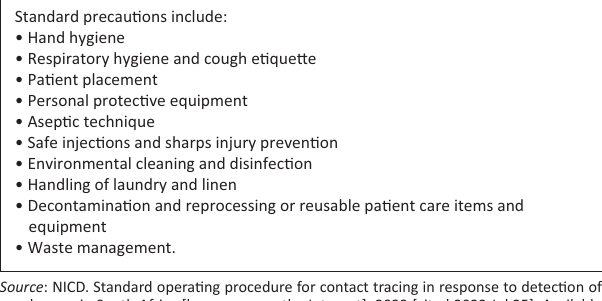
FIGURE 5: Infection prevention and control standard operating procedure for healthcare management of monkeypox